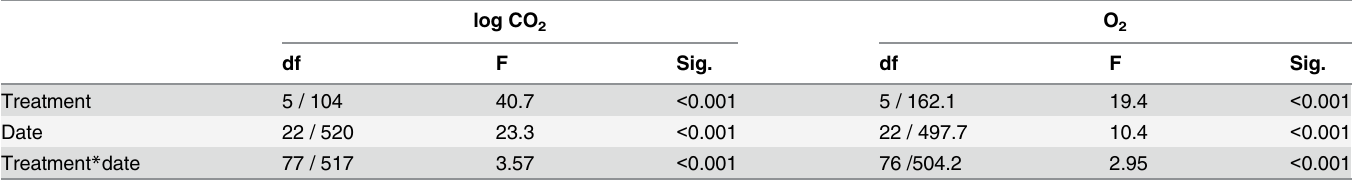
Table 1. Statistical significance tests (linear mixed model for treatment, date and their interaction) for CO 2 (log transformed) and O 2 concentra- tions (%). log CO 2 O 2 df F Sig.